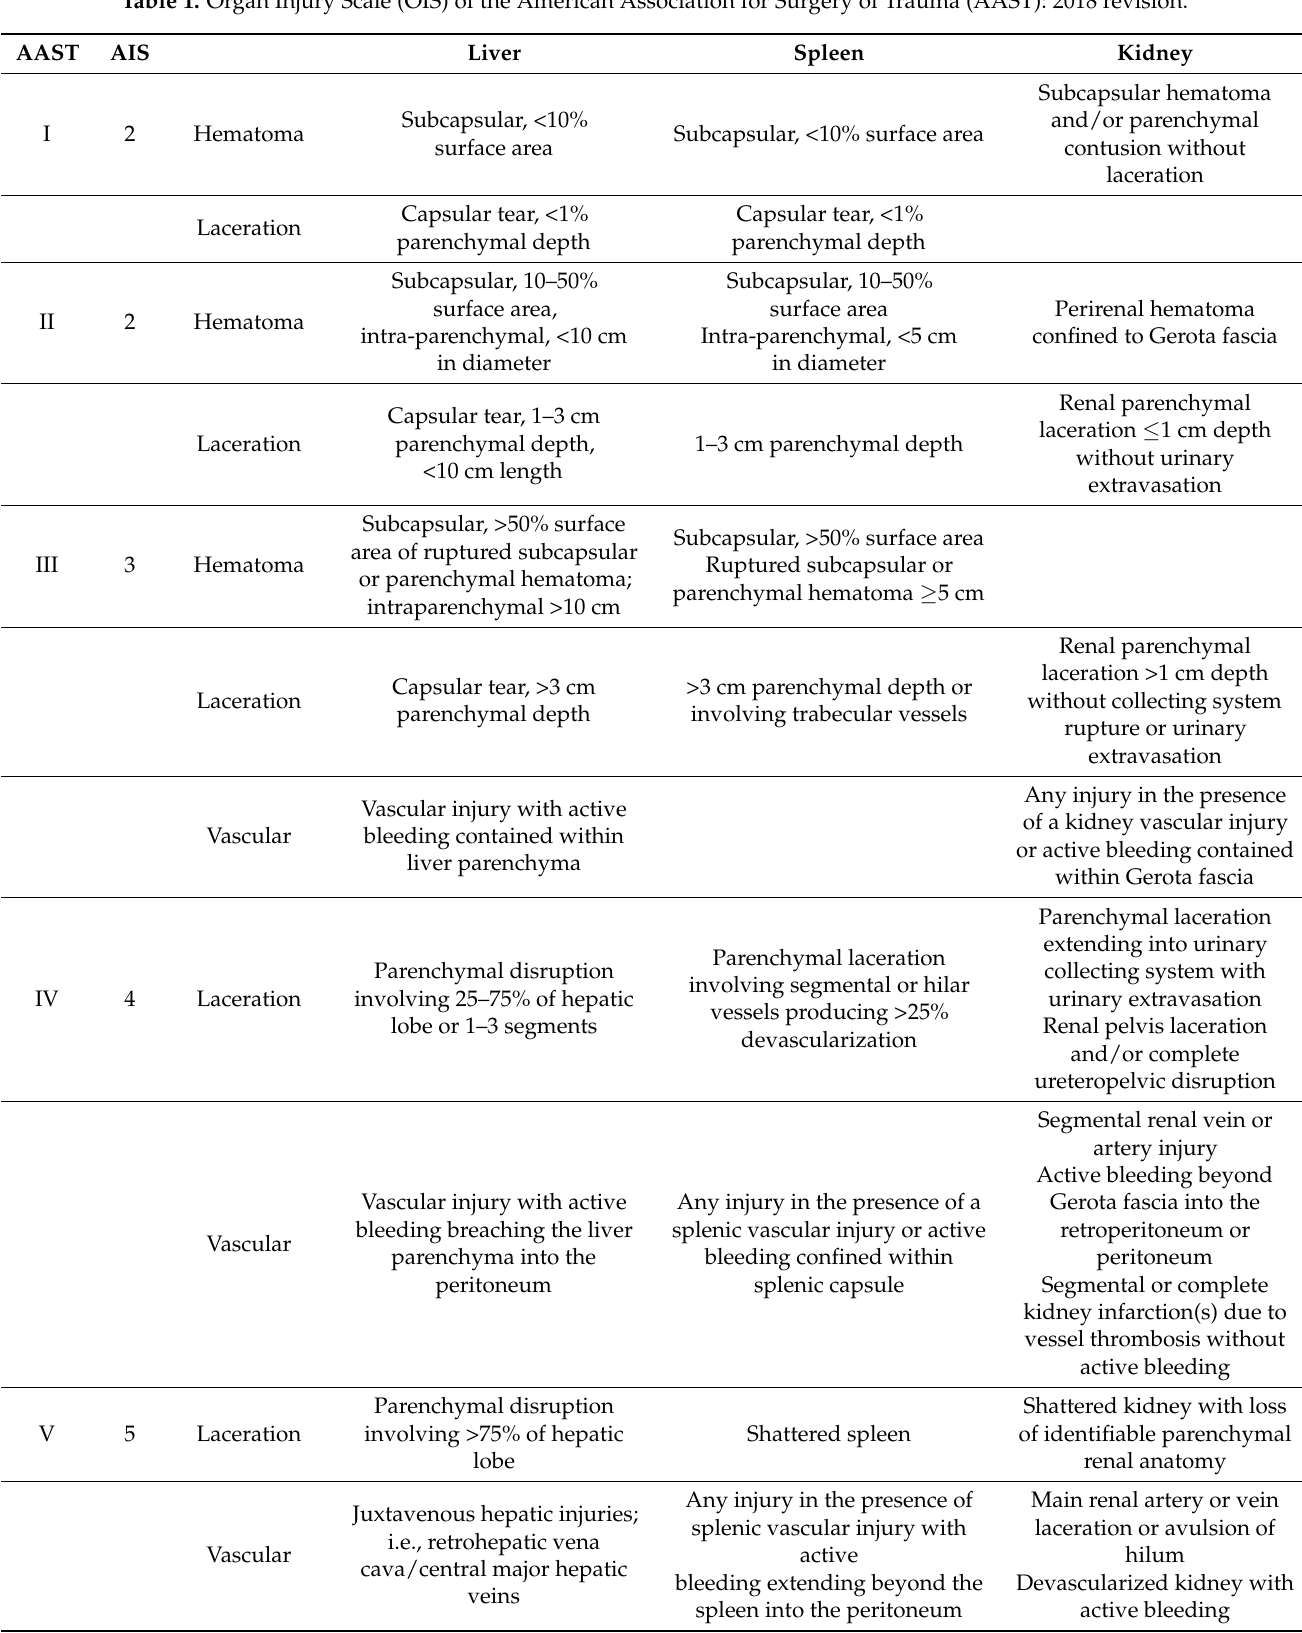
Table 1. Organ Injury Scale (OIS) of the American Association for Surgery of Trauma (AAST): 2018 revision.